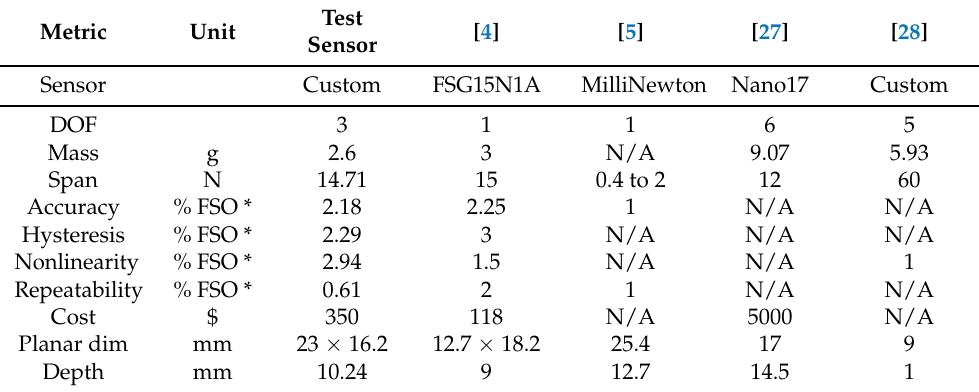
Table 9. Comparative performance of 3-DOF strain sensor to existing sensors used in upper-limb